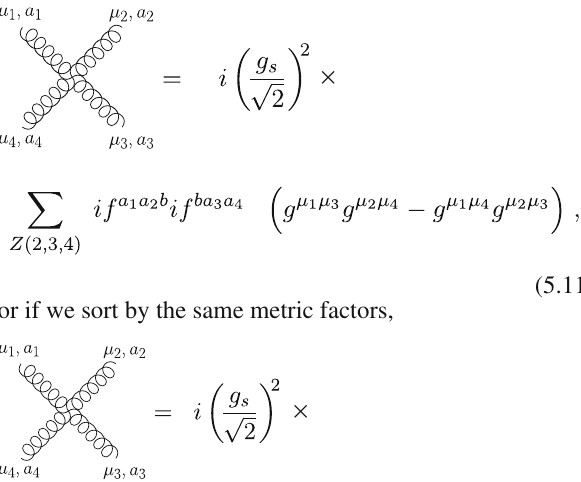
color flows. 13 The lines in the graphs in parentheses